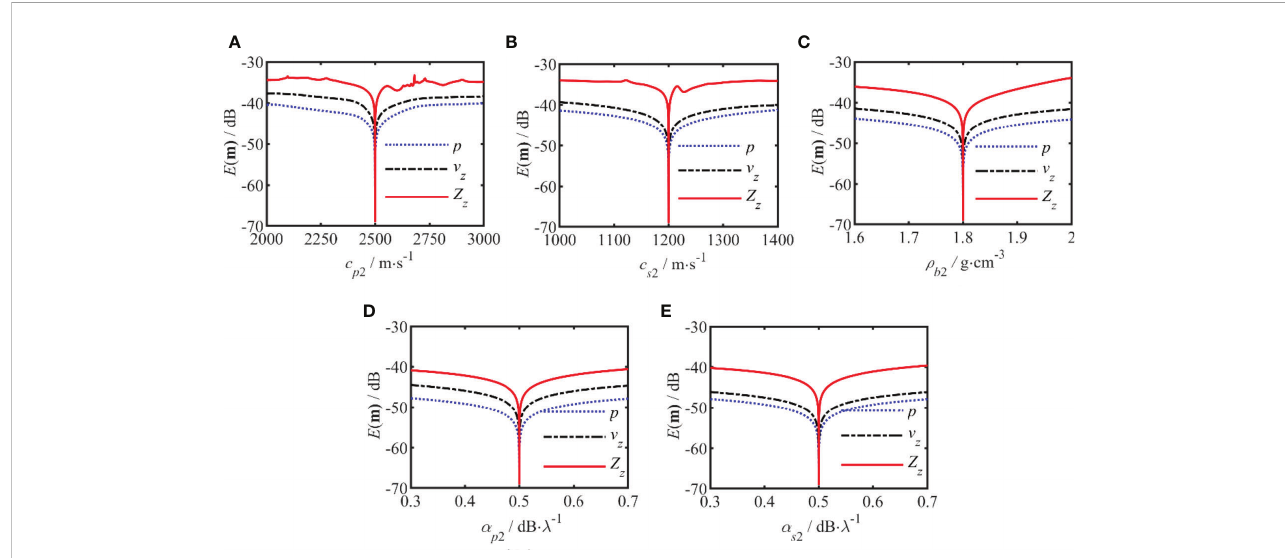
FIGURE 4 The sensitivity analysis of the error function E ( m )) for the geoacoustic parameters of the semi-in fi nite seabed. (A – E) corresponds to the c p 2 , c s 2 , r b 2 , a p 2 , and a s 2 , respectively. The red curve represents for the vertical waveguide characteristic impedance, the black curve represents the vertical particle velocity and blue curve is for the acoustic pressure.